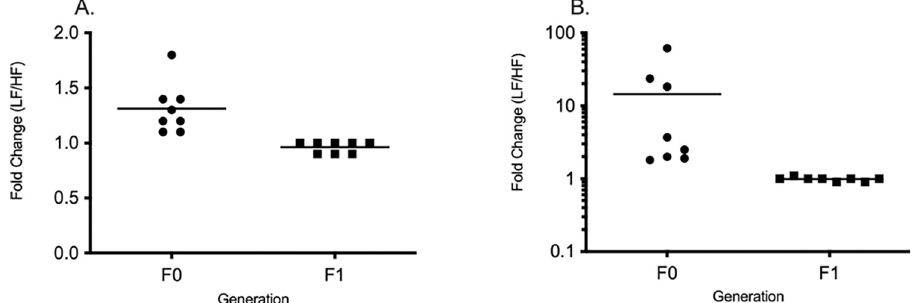
Fig 6. Fold change of embryo viability. Embryo viability measured from the F 0 and F 1 generations were used to calculate the fold change of the LF/HF in both wild-type strains (A) AB, (B) Tu¨. Values that deviate from 1.0 demonstrate a greater difference in reproductive